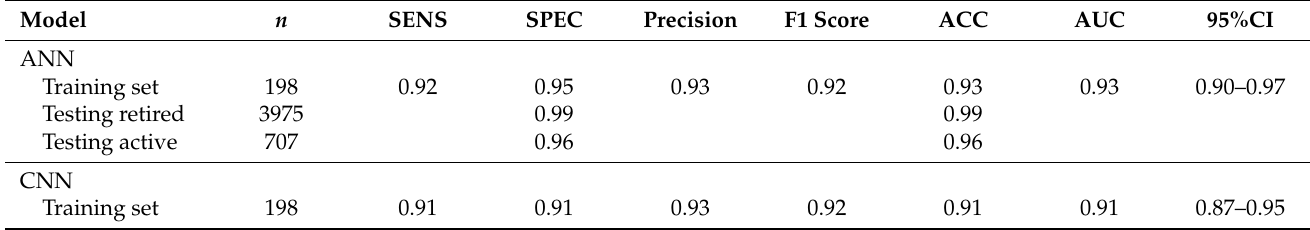
Table 2 Comparison of statistics in models and scenarios.